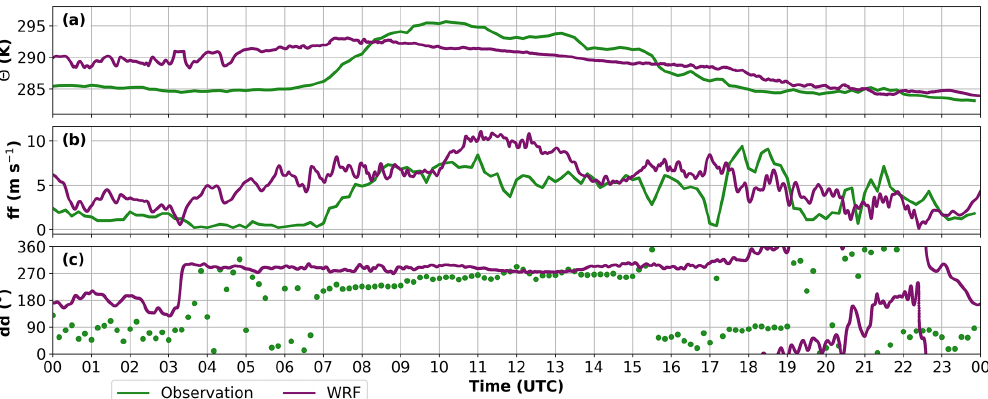
Figure 6. Temporal evolution of (a) potential temperature, (b) wind speed, and (c) wind direction at the University of Innsbruck (UNI) on 29 October 2017. Observations are depicted in green and represent 10min measurements. Model results are depicted in purple as a time series at every integration time step at the WRF grid point closest to